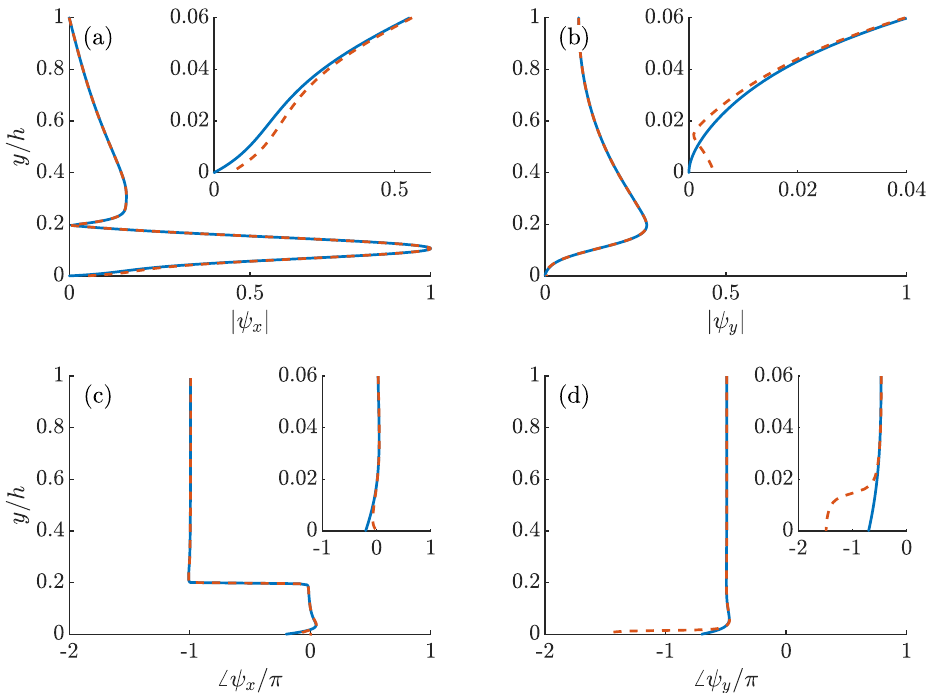
Figure 9. Comparison of the resolvent modes in the ( a , c ) the streamwise direction ψ x , ( b , d ) wall- normal direction ψ y between the rigid wall (blue solid lines) and compliant wall Y = 0.003 i (red dash lines). Figures ( a , b ) are mode amplitudes, and ( c , d ) are mode phases. The resolvent parameters are Re τ = 410, ( k x , k z , c + ) = ( 2.78,0,14.08 ) for both cases. Mode amplitudes are normalized by their peak values, and phases are set to zero at the critical layer. Insets are the near wall close-up views for y / h ≤